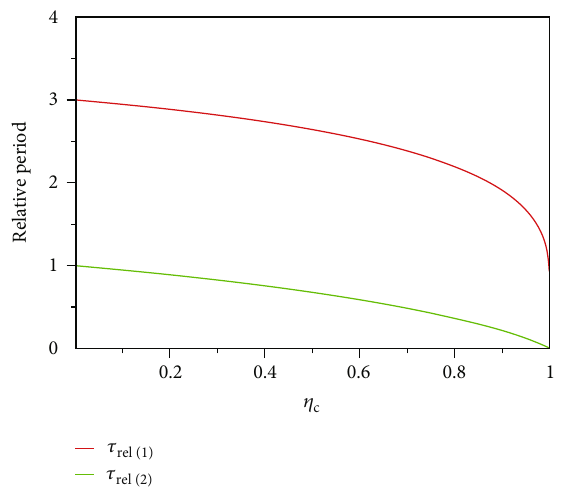
= τ − τ / τ rel opt mp mp ) of the two cases